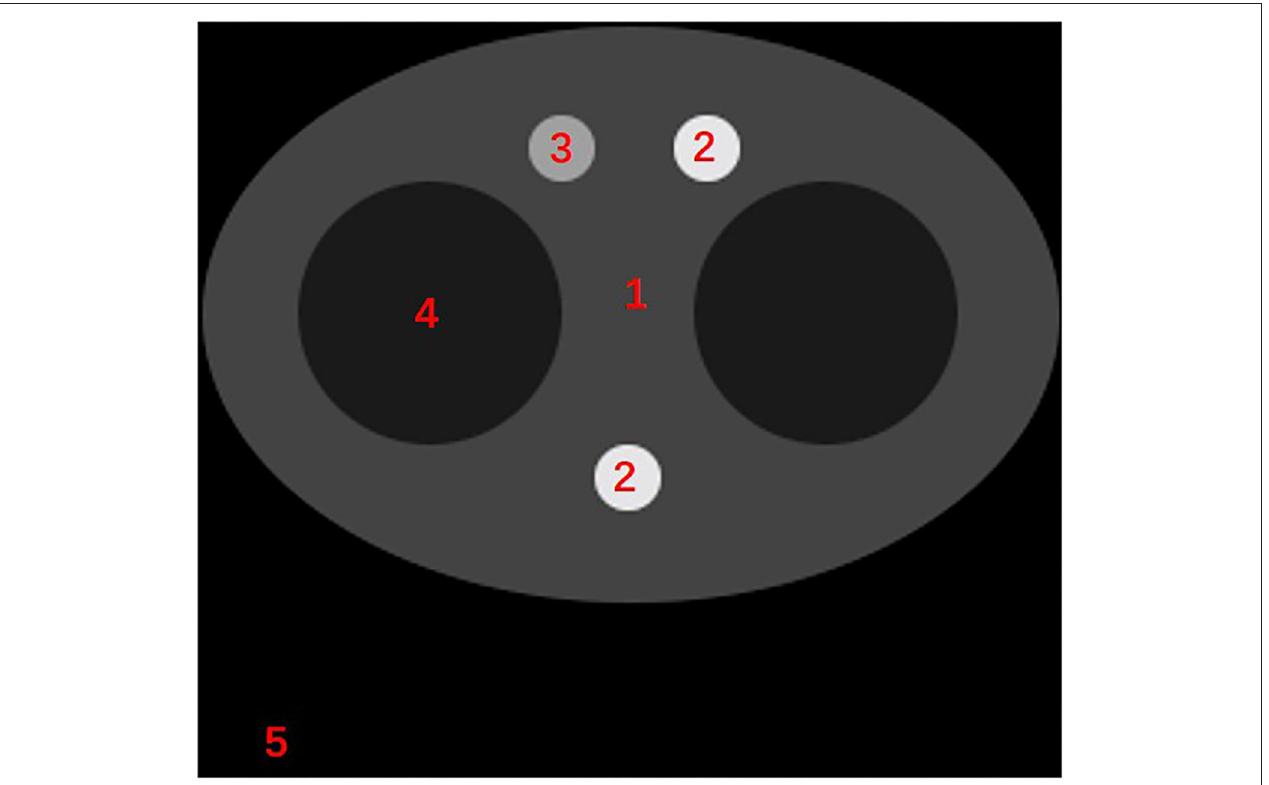
FIGURE 3 | The diagram of the scatter-correction phantom. The materials represented by numbers 1–5 are: adipose tissue, bone, blood and iodine, lung tissue, air.